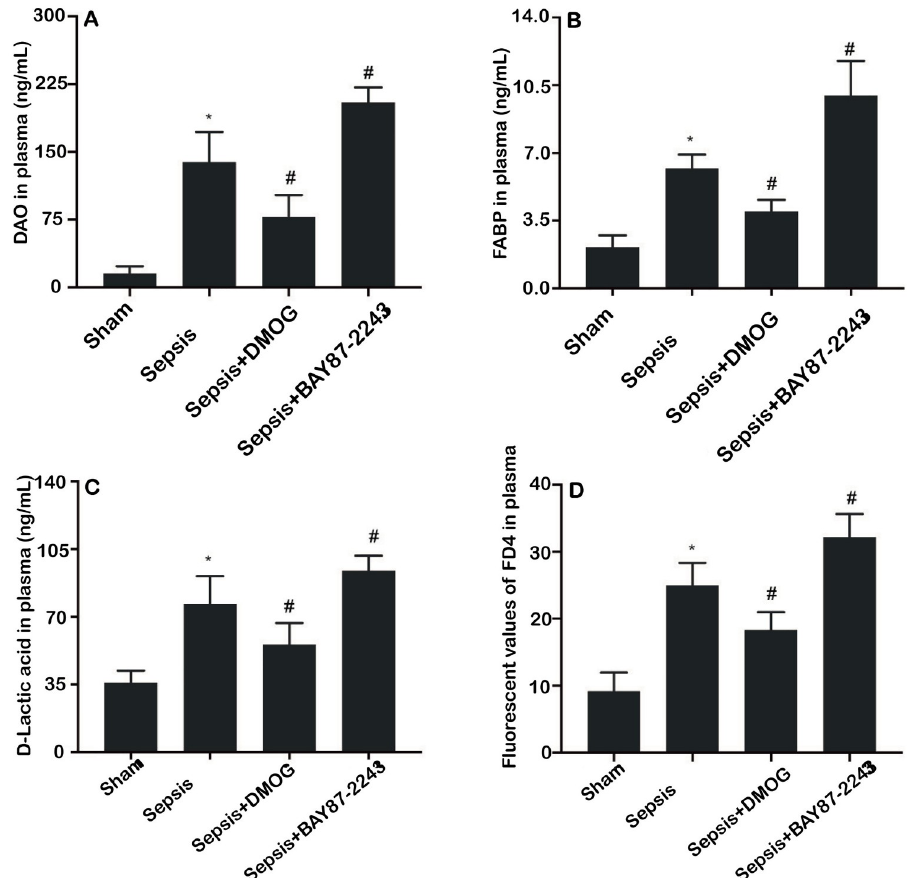
Fig 3. Effects of an HIF-1 α activation/inhibition on the levels of DAO (A), FABP2 (B), and D-lactac acid (C) and the fluorescent signal corresponding to FD4 (D) in the plasma of rats ( n = 6 except sepsis + BAY 87–2243 with n = 5). Data are expressed as the mean (SD); � P < 0.05 compared with the sham group; # P < 0.05 compared with the sepsis group.